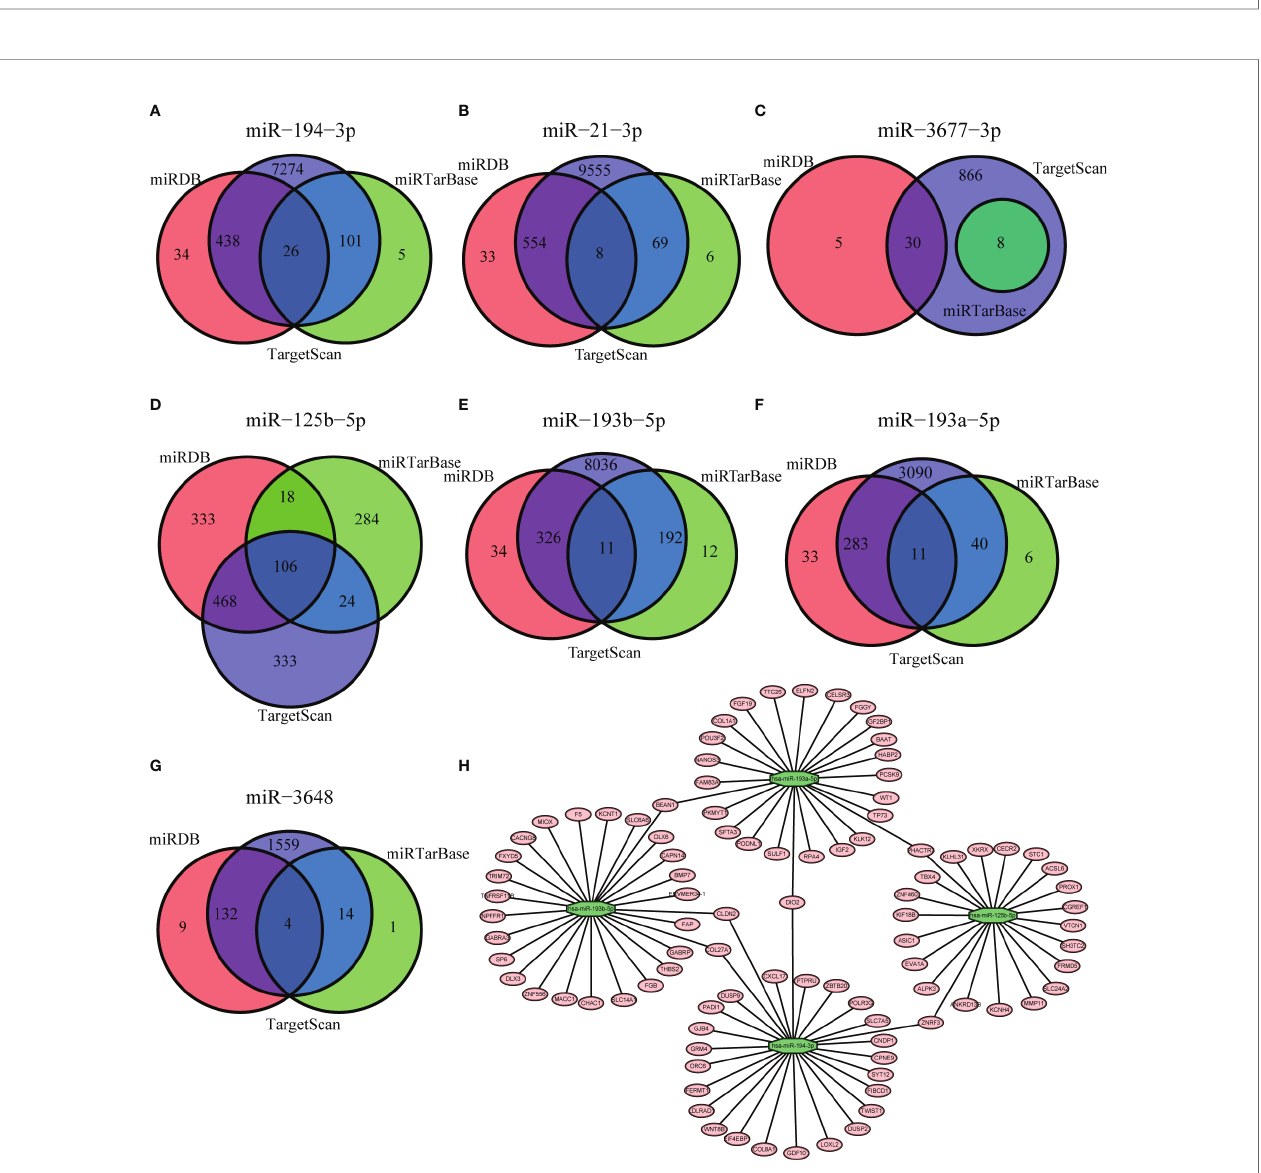
FIGURE 5 | Prediction of genes targeted by each of the miRNAs based on the miRDB (red), miRTarBase (green), and TargetScan (blue) databases ( A – G , Venn diagrams) and the resulting miRNA-mRNA regulatory network (H)